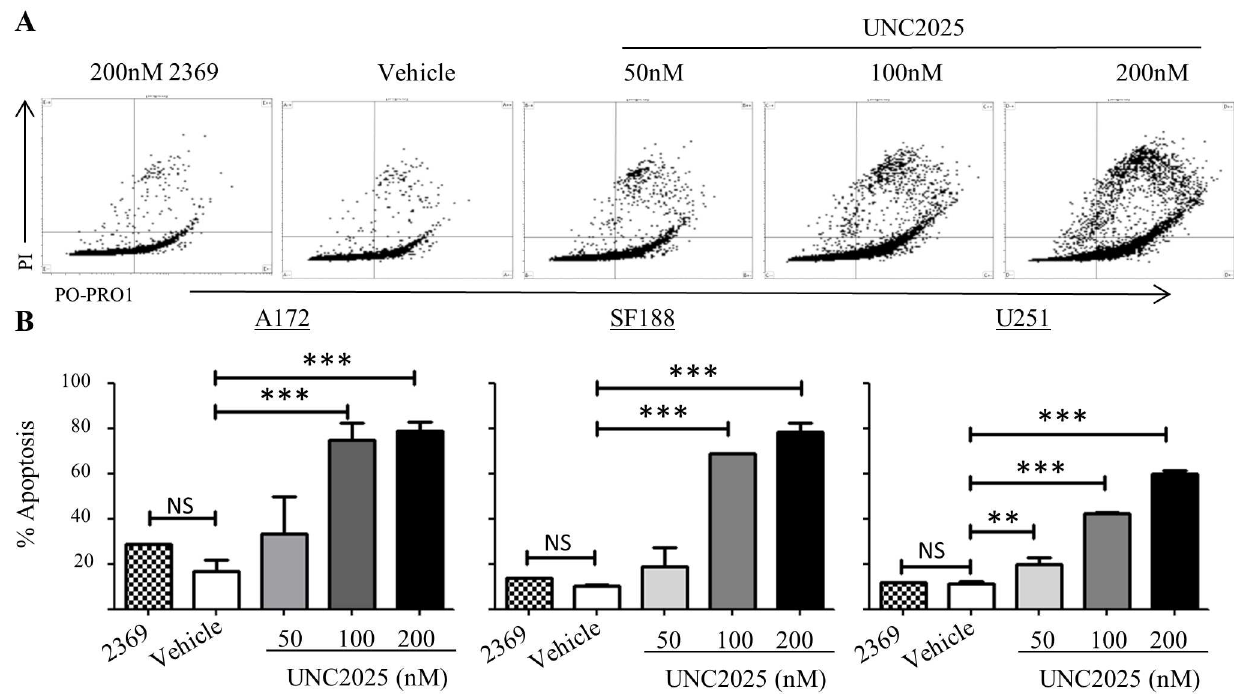
Fig 4. UNC2025 induces cell death in GBM cells. A172, SF188, and U251 cells were treated with UNC2025 (50nM, 100nM, 200nM), control TKI UNC2369(200nM), or vehicle (DMSO) for 72 hours. Cells were stained with Po-Pro-1 and propidiumiodide and analyzedby